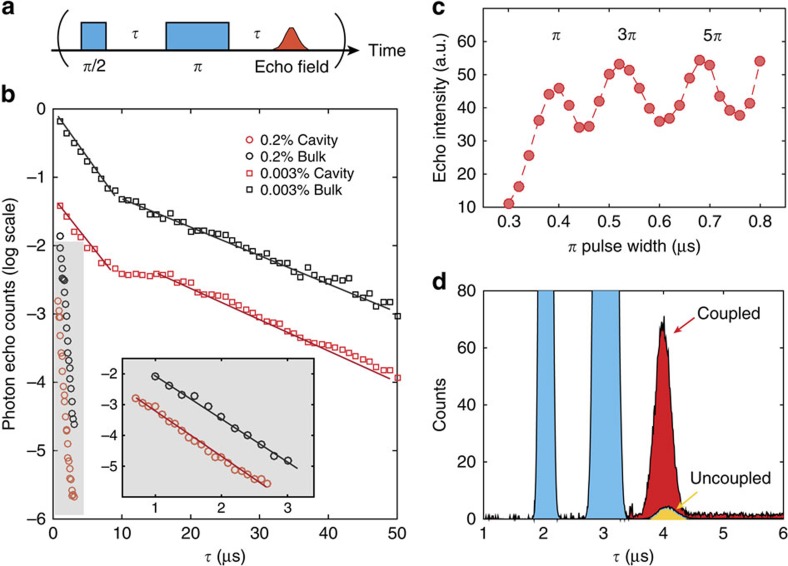
Photon echo measurements from an ensemble of Nd3+ ions in the cavity.(a) Two-pulse photon echo sequence (π/2−π) used to measure T2. (b) Two-pulse photon echo decays measured in both the cavity (red) and the bulk (black) samples with two different doping concentrations. The inset plots the echo decays measured with a 0.2% doped sample. (c) Oscillation of echo intensity with increasing width of the π rephasing pulse. The periodic signal reveals the ensemble averaged Rabi frequency of the coupled ions. The ideal π pulse duration for the input power was 0.4 μs. (d) Enhanced photon echo intensity (by ∼12-fold) when the cavity is coupled, compared with the uncoupled case (cavity detuned by Δλ=15 nm so that the transition is outside the photonic bandgap).